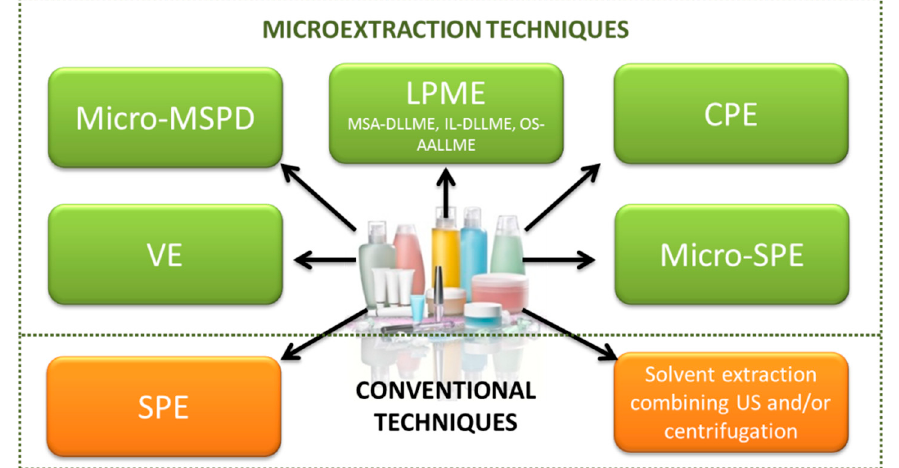
Figure 2. Sample extraction strategies for dyes in cosmetics proposed in the international scientific literature (2008–2018).